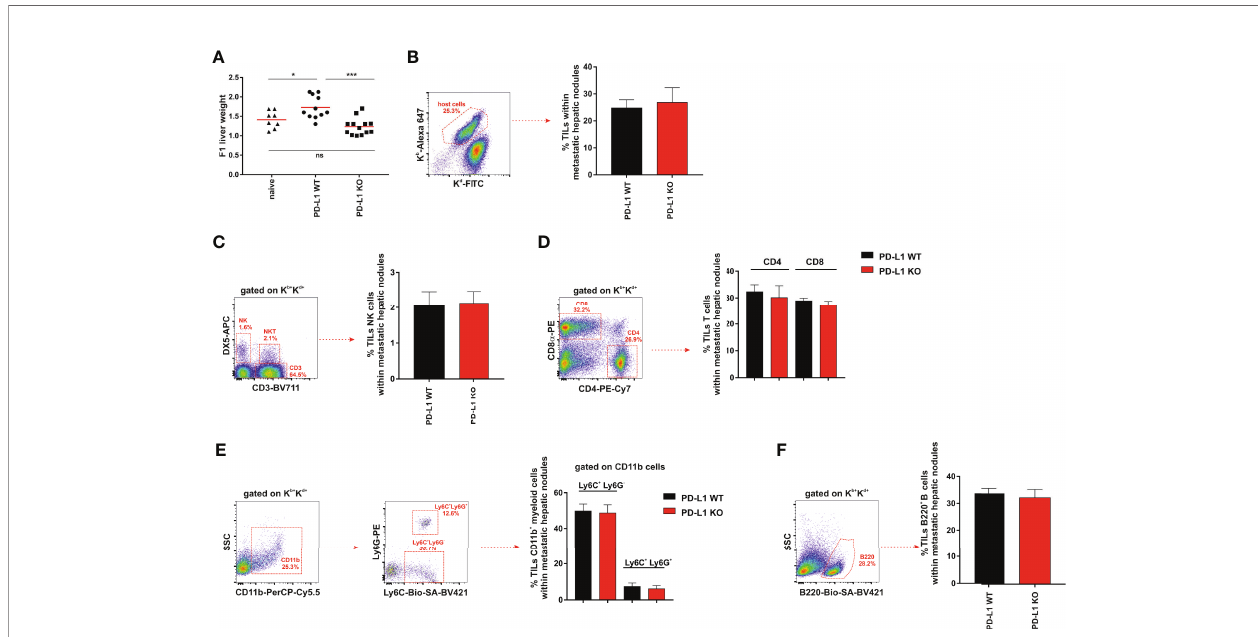
FIGURE 4 | Signi fi cant increase in liver weight in F1 mice receiving A20 PD-L1 WT tumor cells compared to those implanted with A20 PD-L1 KO tumor cells. No substantial changes in tumor leukocyte in fi ltration in metastatic liver nodules arose from either A20 PD-L1 WT or PD-L1-de fi cient tumor cells. (A) The livers of non- treated F1 naive control mice (triangles) and F1 mice injected with either A20 PD-L1 WT (circles) or KO tumor cells (squares) were weighted at the time of the necropsy, 1 month after tumor injection. (B) The frequency of tumor-in fi ltrating leukocytes (TILs) in metastatic nodules of the liver was calculated and represented. The percentages of NK cells (CD3 − /DX5 + ) (C) , CD4 and CD8 T cells (D) , CD11b + /Ly6C + /Ly6G − (monocytes) and CD11b + /Ly6C + /Ly6G + (granulocytes) (E) , and B cells (B220 + ) (F) were analyzed in metastatic liver nodules of F1 recipients engrafted with A20 PD-L1 WT or A20 PD-L1 KO tumor cells. Representative dot plots depicting the gating strategy and the subpopulations of each analysis are shown. The bar graph shows the mean ± SEM from 10 to 15 mice per group. p -values were considered statistically signi fi cant according to the following criteria: * p < 0.05; *** p < 0.0005. WT, wild type; KO, knockout. Unpaired Student ’ s t -test was used for the evaluation of the statistical signi fi cance of the